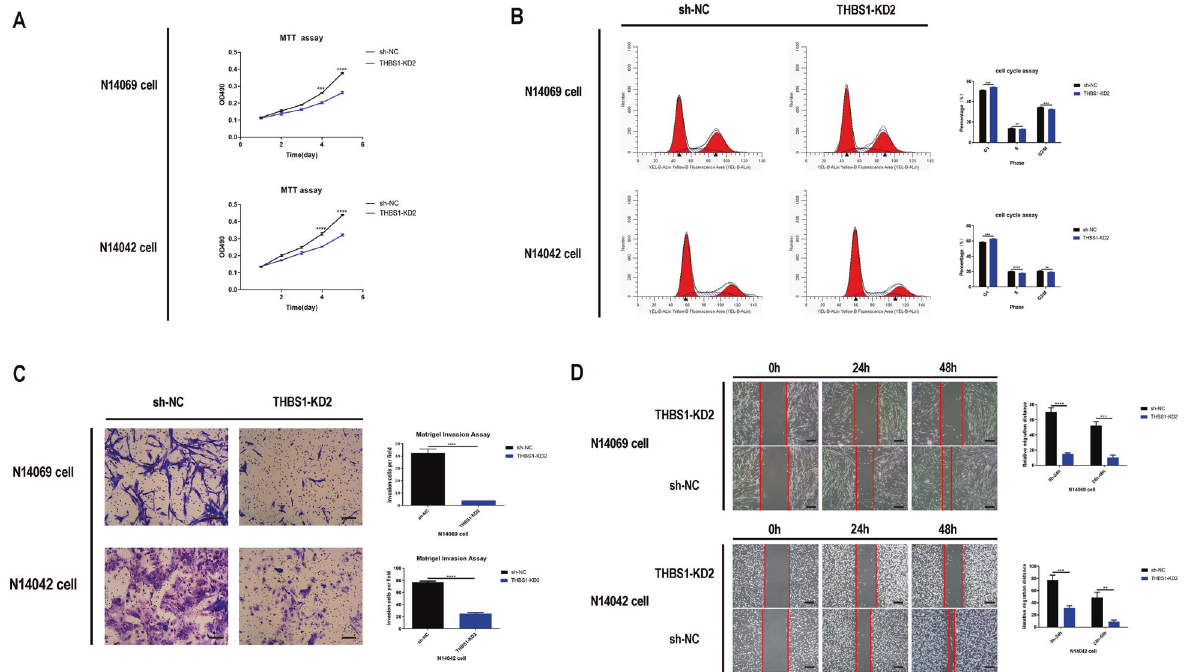
Fig. 4 Knockdown of thrombospondin 1 (THBS1) inhibits the proliferation, migration, and invasion of glioma cells. A Representative proliferation curves showed that glioma cell proliferation was signi fi cantly inhibited following THBS1 knockdown. B Representative fl ow cytometry pro fi les and corresponding histograms showed that THBS1 downregulation led to cell cycle arrest of glioma cells at the G1 phase. Representative images and corresponding histograms of C Transwell migration (×100 magni fi cation) and D scratch assay (×40 magni fi cation) results showed that THBS1 downregulation signi fi cantly inhibited the migration and invasion ability of glioma cells, respectively. Data are shown as mean ± standard deviation (SD), n = 3, * p < 0.05, ** p < 0.01, *** p < 0.001, **** p < 0.0001, Student ’ s t test.